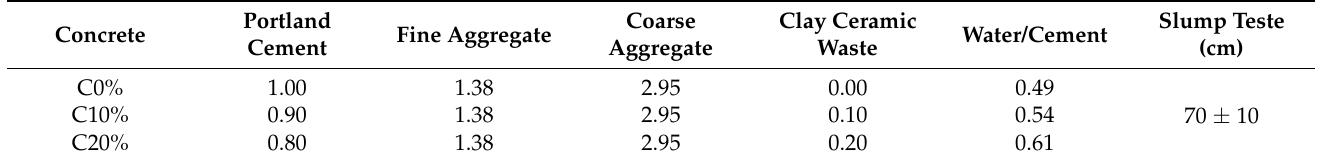
Table 3. Proportion of materials used in